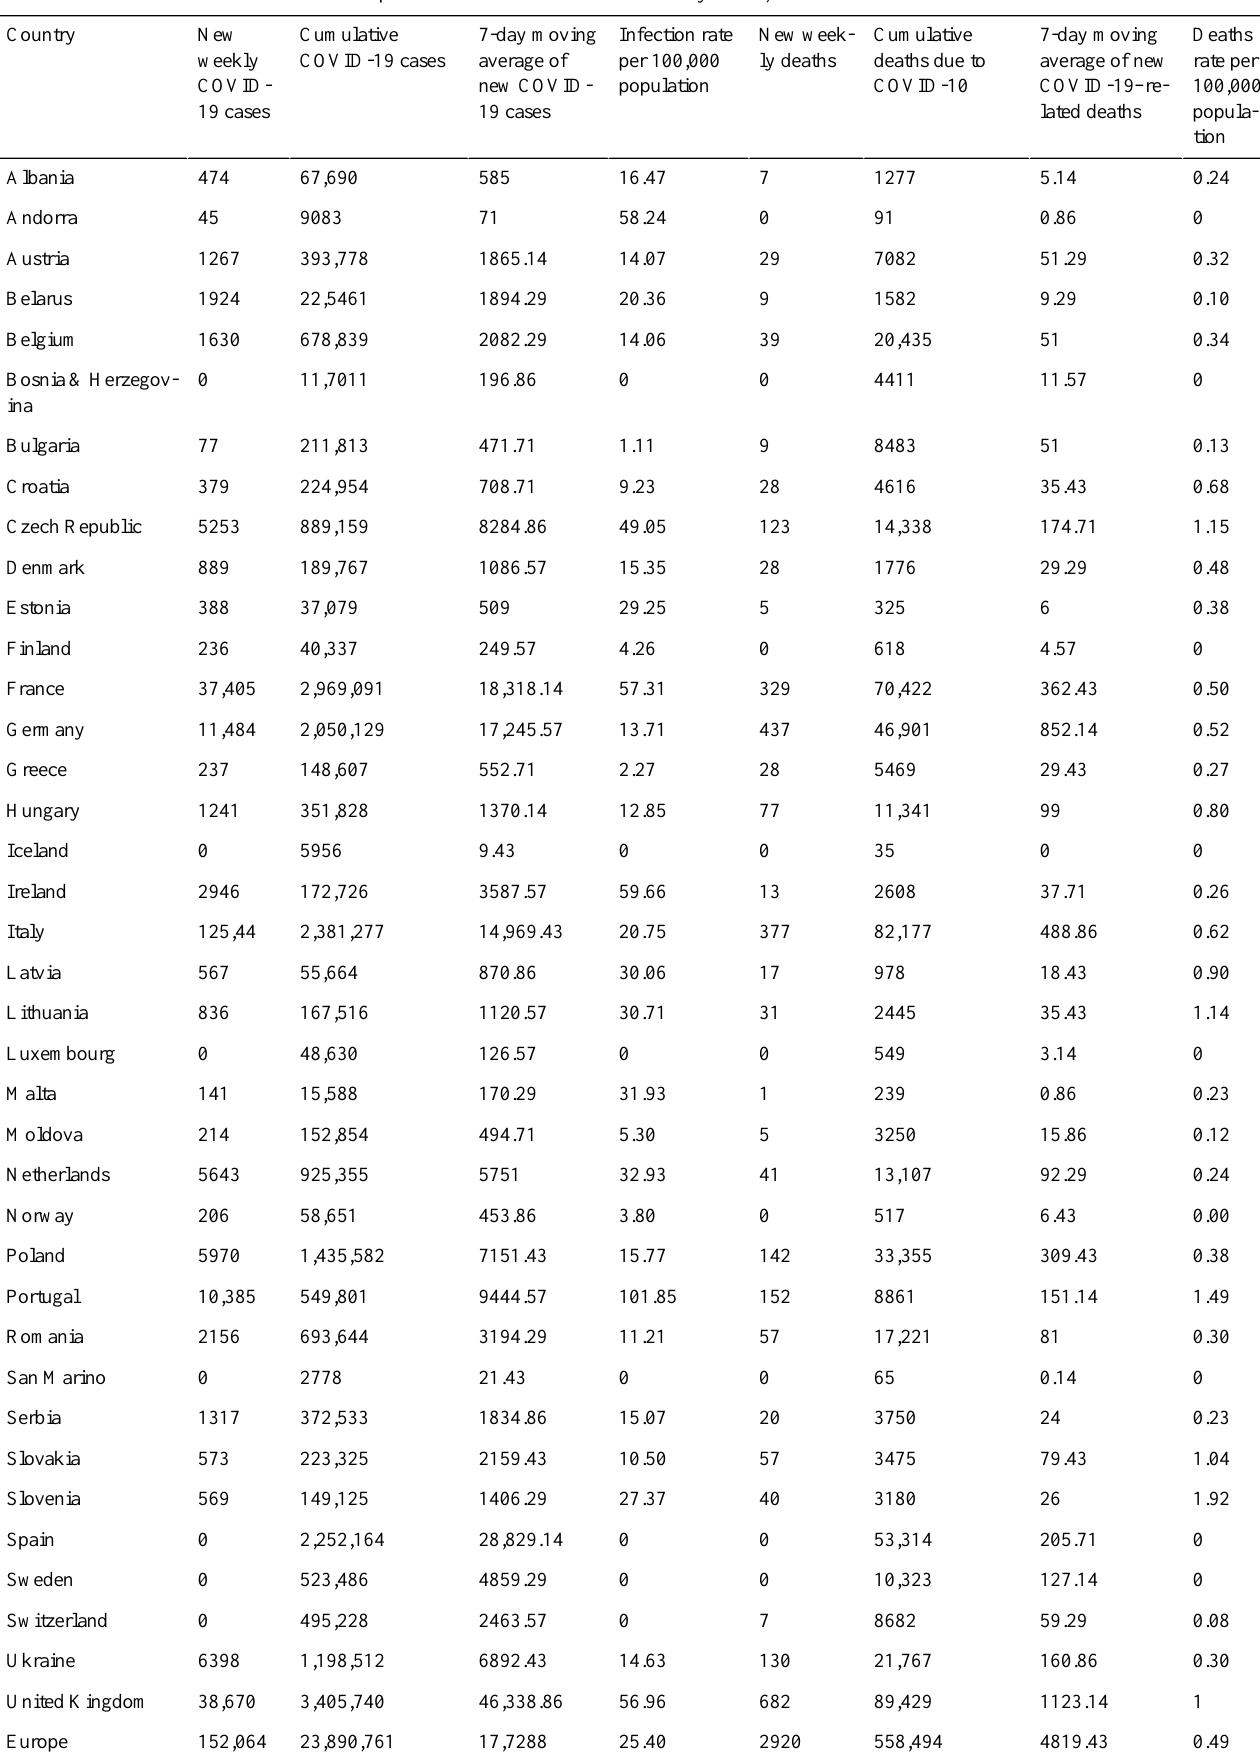
Table 3. Static surveillance metrics for European countries for the week of January 11-17,